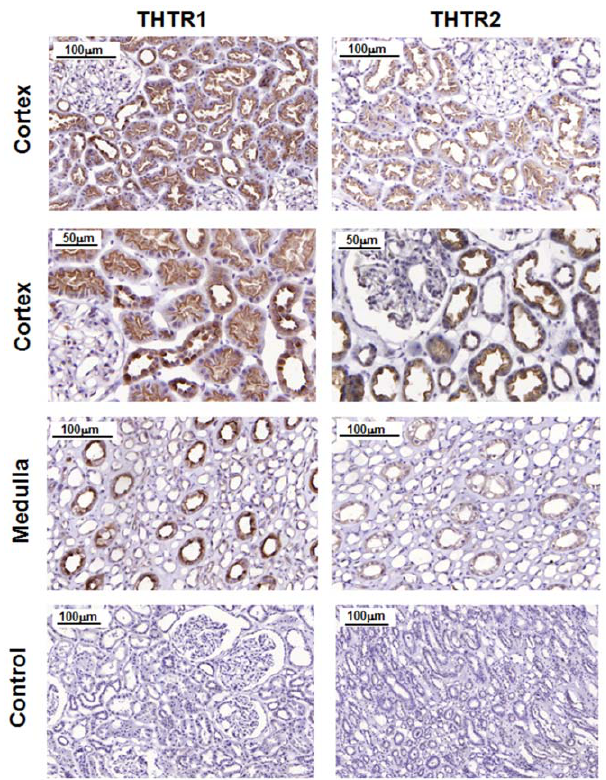
Figure 1. Protein expression of thiamine transporters in human kidney, immunostaining for THTR-1 and THTR-2. Cortex - THTR- 1: Intense polarised staining of the apical, luminal membranes in proximal tubules. THTR-2: similar staining to THTR-1 in proximal tubules. Distal tubules - Cellular staining throughout, stronger for THTR-1 than THTR-2 protein. Glomeruli: no staining for both proteins. Medulla - uniform, diffuse staining throughout cells of the collecting duct for THTR-1 and THTR-2, with much stronger staining for THTR-1. Image shows brown 3,3 9 -diaminobenzidine stain with blue haematox- ylin-counterstaining of nuclei. Control tissue: omission of primary antibodies. doi:10.1371/journal.pone.0053175.g001 glucose. Changes in mRNA were: SLC19A2 , 2 76% ( P , 0.001),